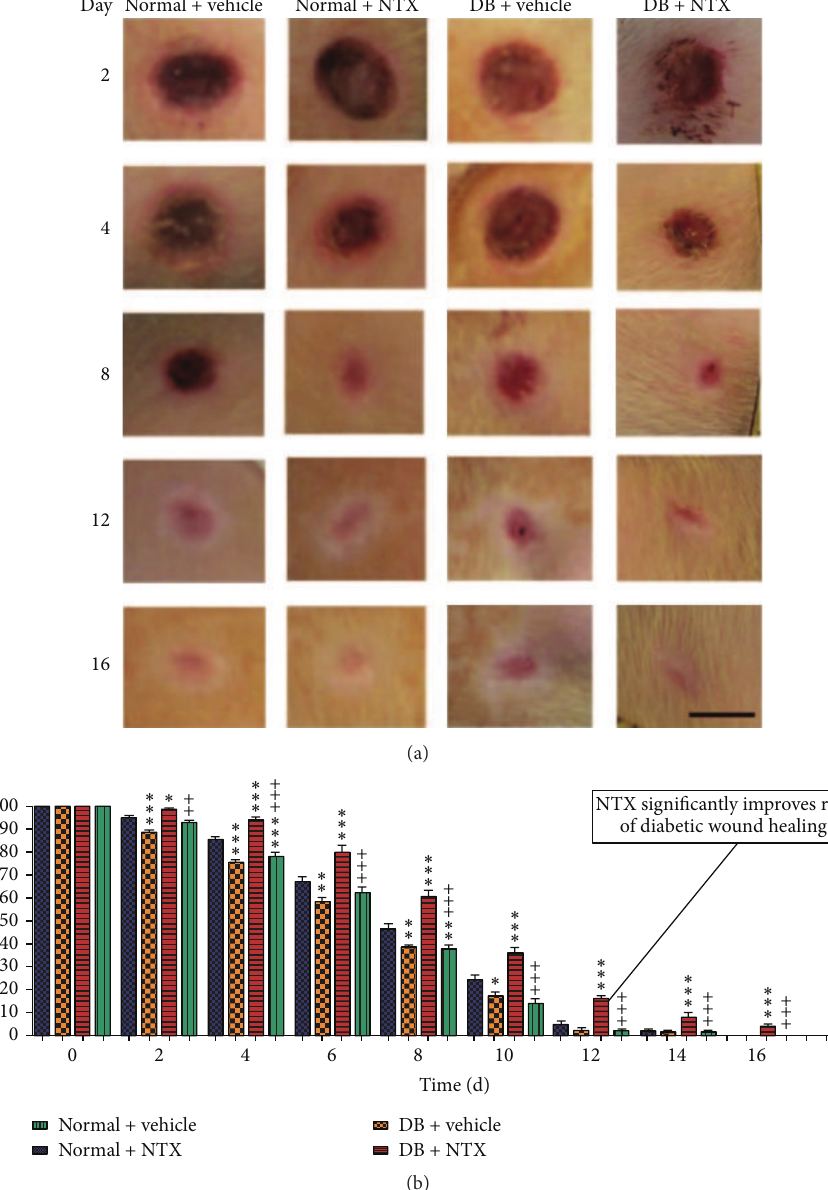
Figure 19: Full-thickness wound closure following application of topical NTX to normal and hyperglycemic rats. (a) Full-thickness wounds created on the dorsal surface of normal and type 1 diabetic rats. Wounds were treated three times daily with either 10 −5 mol/L NTX (NTX) or saline (vehicle) dissolved in Neutrogena moisturizing cream. Photographs were taken every other day for 18 days. Bar=5 mm. (b) Histograms of residual defects as a % of the original wounds. Groups were treated with either NTX or vehicle over an 18-day period of time. Diabetic NTX-treated rats (DB + NTX) had wounds 62–89% smaller compared to DB controls (DB + vehicle). Diabetic NTX-treated rats (DB NTX) had wounds 62–89% smaller than DB controls. Significantly different from normal + vehicle measurements at ∗ 𝑃 < 0.05 , ∗∗ 𝑃 < 0.01 , and ∗∗∗ 𝑃 < 0.001 ; significantly different from DB + vehicle group at ++ 𝑃 < 0.01 and +++ 𝑃 < 0.001 . NTX: naltrexone; DB: diabetic (derived from